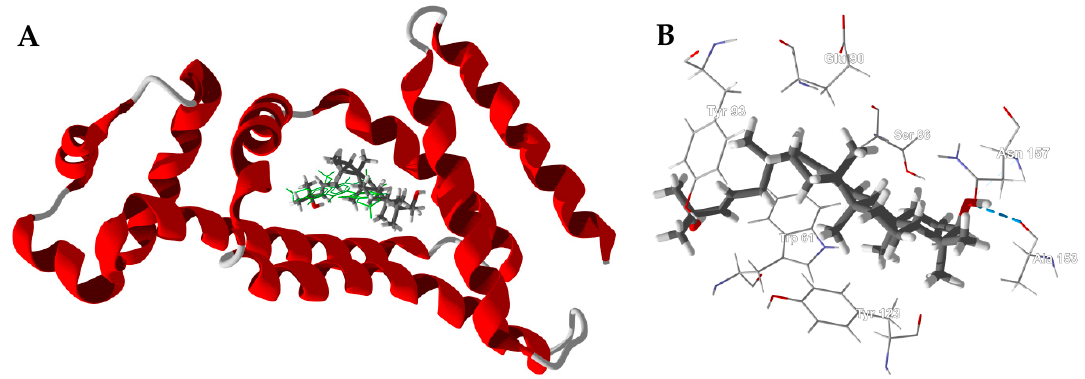
Figure 10. Lowest-energy docking pose of olibanumol J with Staphylococcus aureus multidrug binding protein (SaQacR, PDB 3bti). ( A ): Ribbon structure of SaQacR showing olibanumol J ( E dock = − 132.6 kJ/mol) in the active site. The co-crystallized ligand, berberine ( E dock = − 113.8 kJ/mol), is shown as a green wire structure. ( B ): Key interactions of olibanumol J in the active site of SaQacR. The hydrogen-bond is indicated by a blue dashed line.